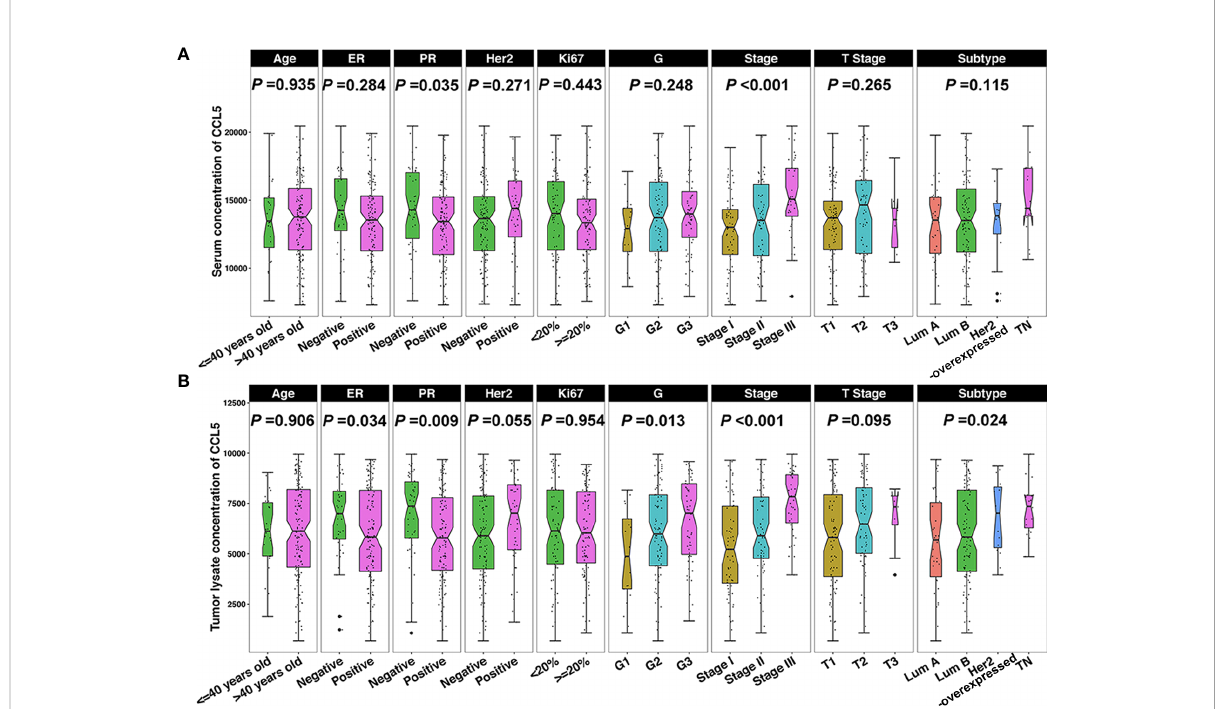
FIGURE 3 (A) The serum CCL5 concentration is correlated with PR and clinical stage, and (B) CCL5 levels in tumors are correlated with ER, PR, nuclear grade, clinical stage, and molecular subtype. ER, estrogen receptor; PR, progesterone receptor; Her2, human epidermal growth factor receptor; G, nuclear grade; Lum, luminal; TN, triple